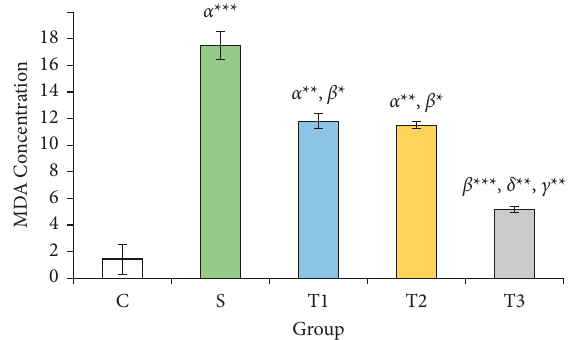
column represents the mean ± standard error (mean ± SEM). ∗ P < 0 . 05 and ∗∗ P < 0 . 01. α and β compared with groups C and S , respectively.